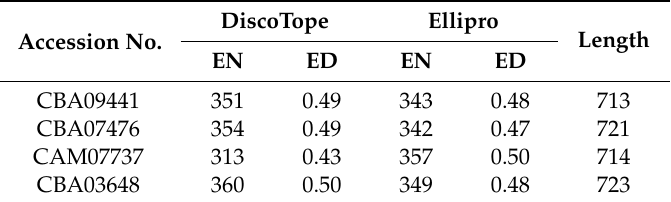
Table 4. Conformational B-cell epitope densities of proteins predicted with DiscoTope, and